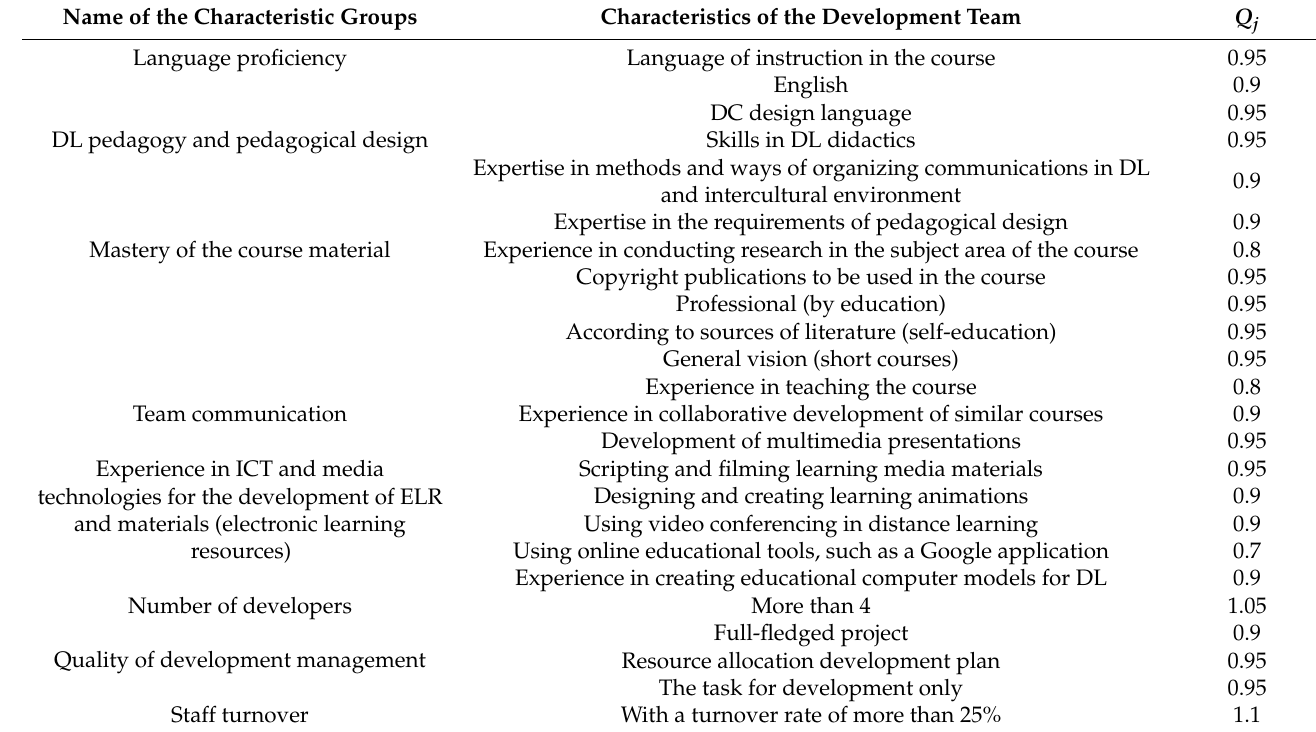
Table 2. Characteristics for assessing the skill level of a group of DC